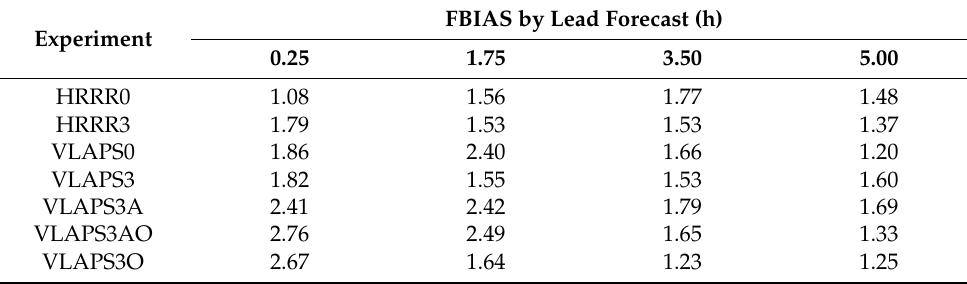
Table 5. FBIAS for 35 dBZ threshold at four different lead forecast times (h). Experiment